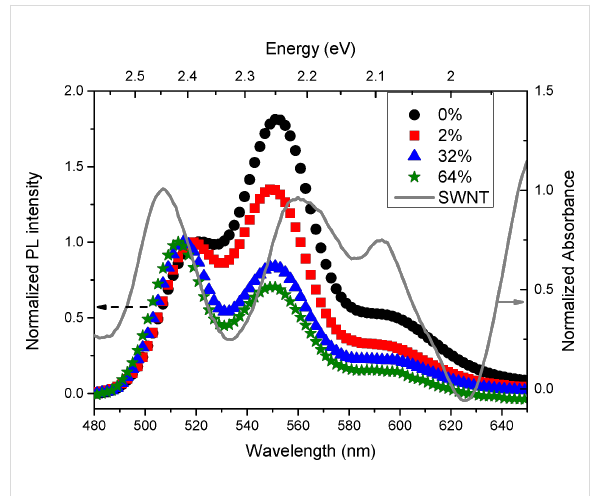
Figure 5: Left side: steady-state PL of PPV/SWNT composite films for different SWNT mass percentages x . Right side: absorption spectrum of semiconducting and metallic SWNTs. The excitation energy of emis- sion spectra is E exc = 3.1